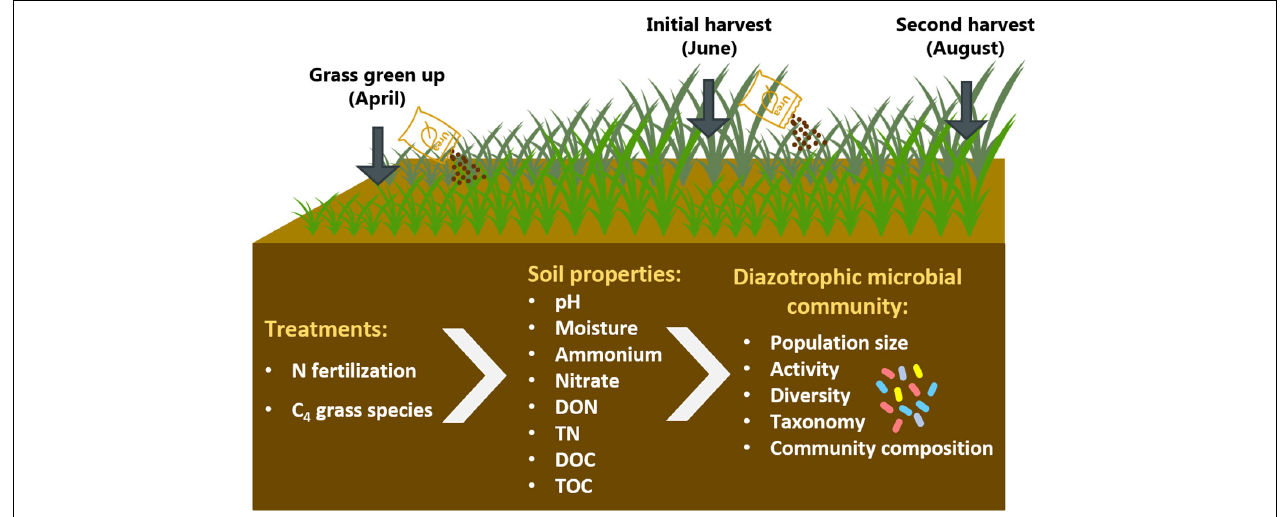
FIGURE 1 | Schematic overview of the study.